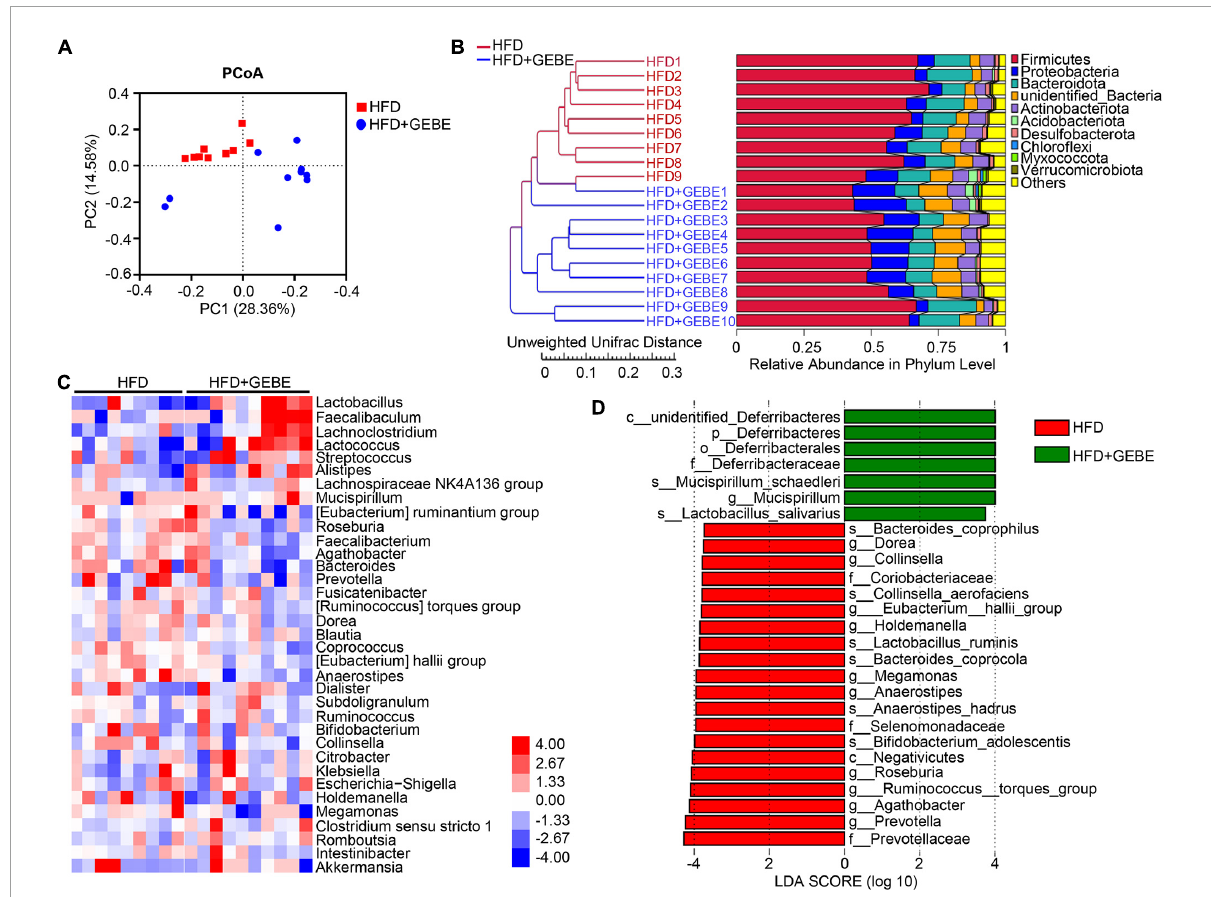
FIGURE2 GEBE regulates the gut microbiota in HFD-induced C57BL/6 mice ( n = 9–10). (A) Principal coordinate analysis (PCoA) based on unweighted UniFrac distances. (B) Unweighted UniFrac analysis using unweighted pair group method with arithmetic mean (UPGMA) clustering analysis. (C) Heatmap of gut microbiota at the genus level in mice. (D) Discriminative taxa determined by LEfSe between two groups (log10 LDA > 3.73). HFD: High-fat diet; HFD + GEBE: High-fat diet with GEBE.